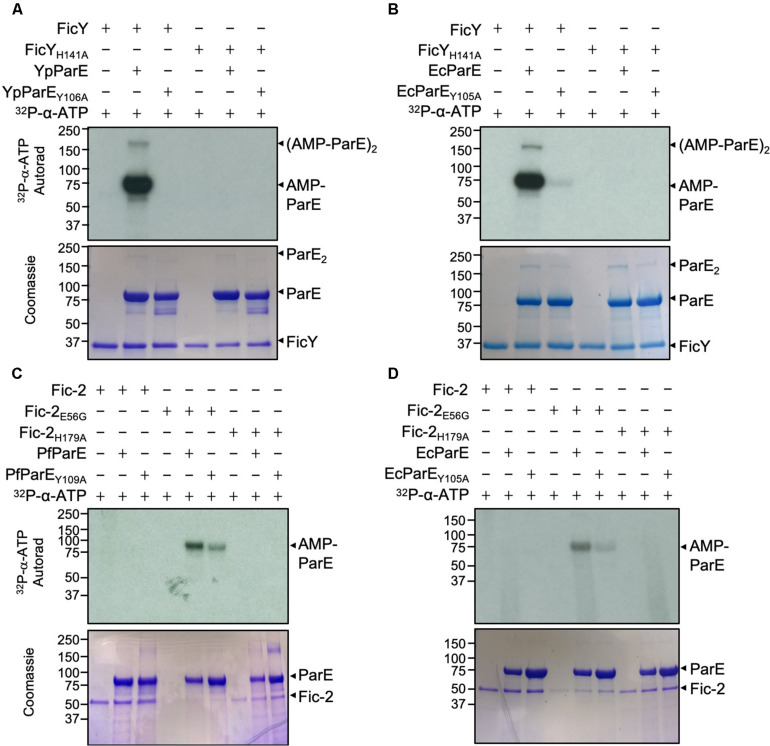
FicY and Fic-2 modified YpParE at Tyr106 and PfParE at Tyr109. (A,B) FicY from Y. pseudotuberculosis AMPylates YpParE at Tyr106 and EcParE at Tyr105. (C,D) Fic-2 of P. fluorescens modified PfParE at Tyr109 and EcParE at Tyr105. Signals were detected by 2.5 h (A,C,D) and 5 min (B) exposure. The predicted molecular mass of His6-SUMO tagged FicY, Fic-2, PfParE, EcParE, and YpParE is 37.44, 52.20, and 83.33, 84.04, and 83.79 kDa, respectively. Note that the Y106A or Y109A mutant of YpParE or PfParE can no longer be modified by FicY or Fic-2. The constitutively active form of Fic-2 (Fic-2E56G) significantly modified wild type PfParE and EcParE but not PfParEY109A and EcParEY105A.